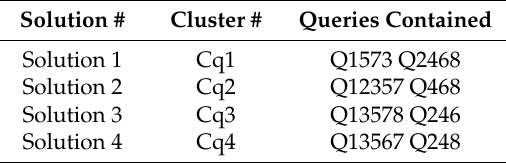
Table 9. Solution